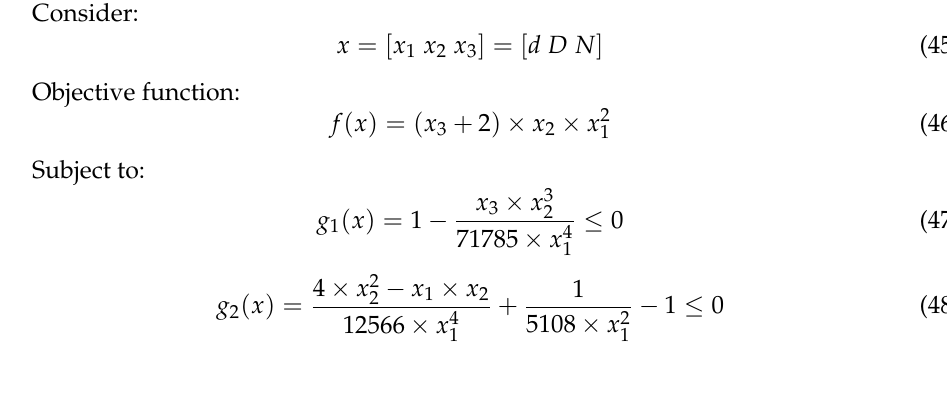
Figure 12. Model of tension/compression spring design.